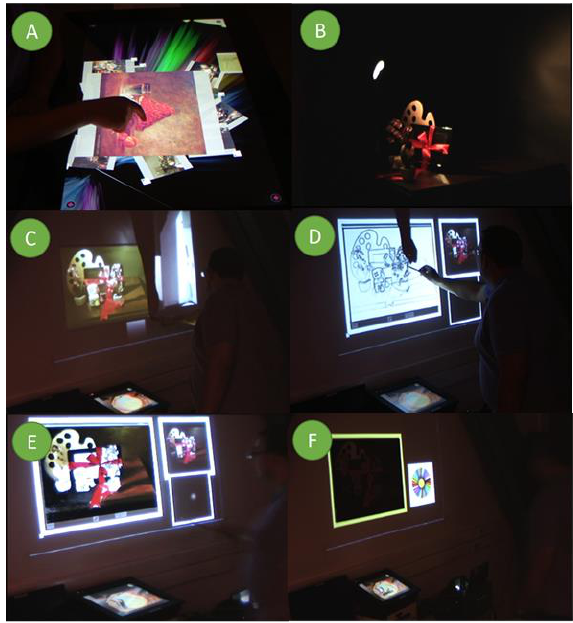
Figure 5. Intermediate steps for the creation a still life composition using the